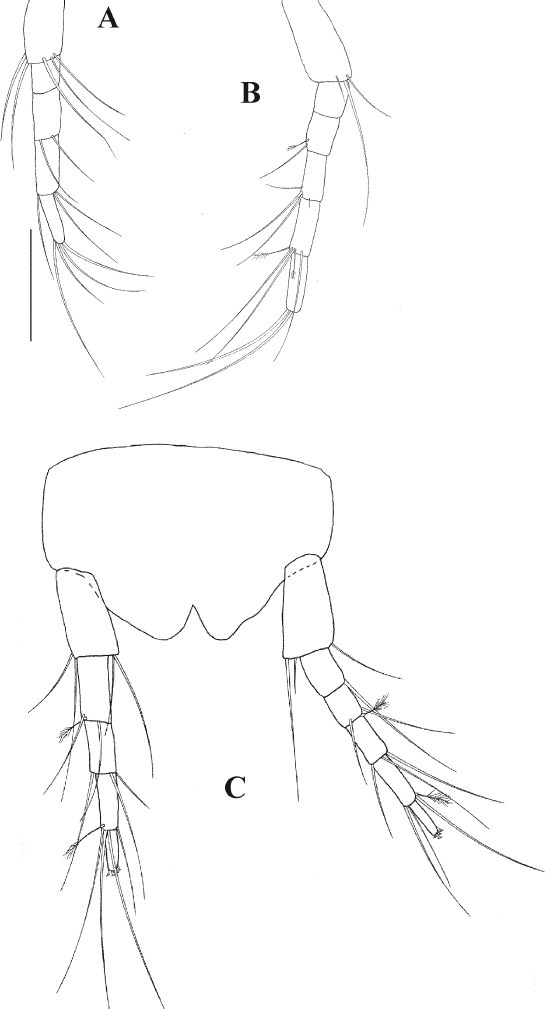
Fig. 2. – Uropod articulation. A, Zeuxo sp. A (Korea), left uropod. B, Same, right uropod. C, Z. exsargasso , uropods. Scale bar, 0.5 mm.